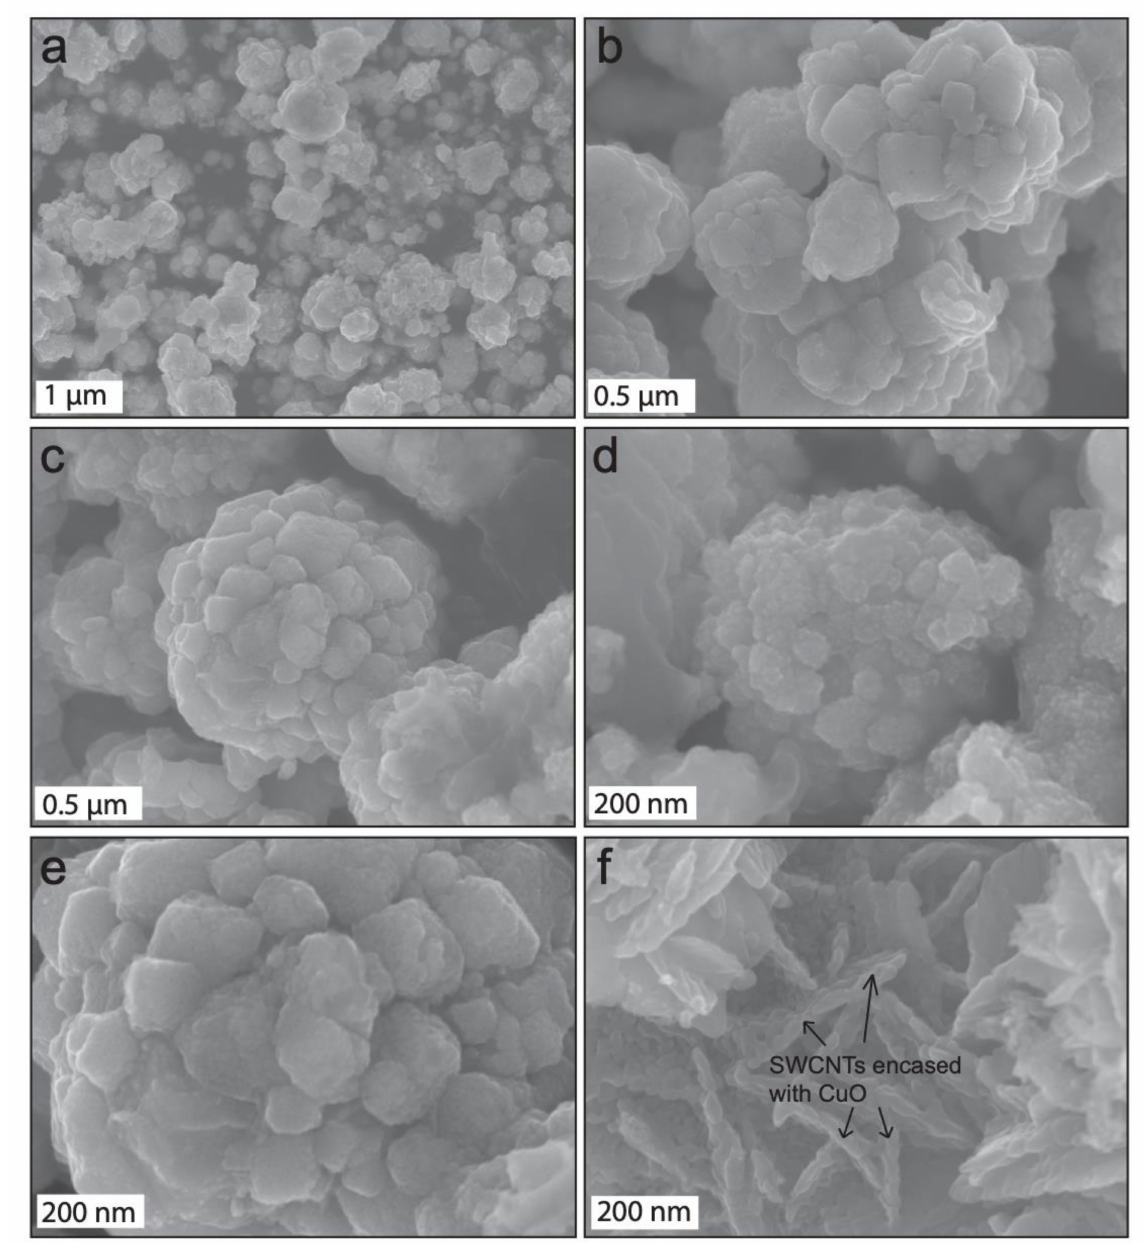
Figure 1. Representative field emission scanning electron microscopy (FE-SEM) micrographs of nanocomposites: CuOSC-1 ( a ) and ( b ), CuOSC-2 ( c ) and ( d ), and CuOSC-3 ( e ), exhibiting an interesting cauliflower-like architecture and ( f ) the chemical association of CuO and carbon nanotubes with single walls (SWCNTs) in the CuOSC-1